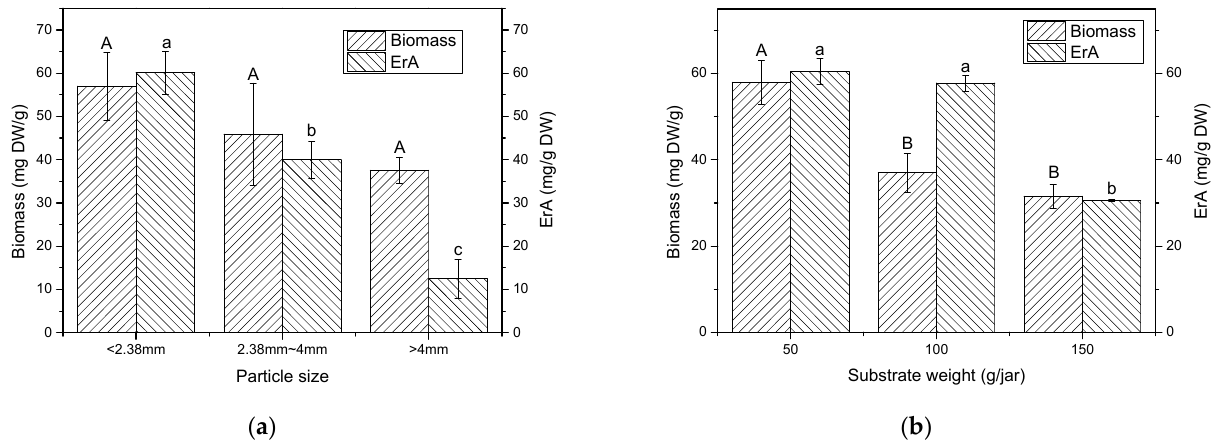
Figure 5. The effect of ( a ) substrate particle size and ( b ) substrate amount on the mycelial biomass and specific yield of ErA. Different superscripts in upper case indicate significant difference ( p < 0.05) in biomass, and different superscripts in lower case indicate significant difference ( p < 0.05) in specific yield of ErA.